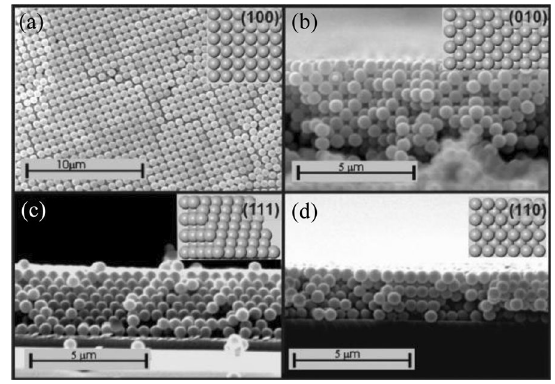
Figure 11 SEM images of different crystal faces found in the top view and side view of [99] oriented silica colloidal crystal grown by spin coating (The crystal is made of silica dispersion in ethanol, which contains 30% particle volume fraction): a Top view corresponding to (100) planes; b Vertical (100) plane; c Inclined (111) plane and d Vertical (110) plane [67]